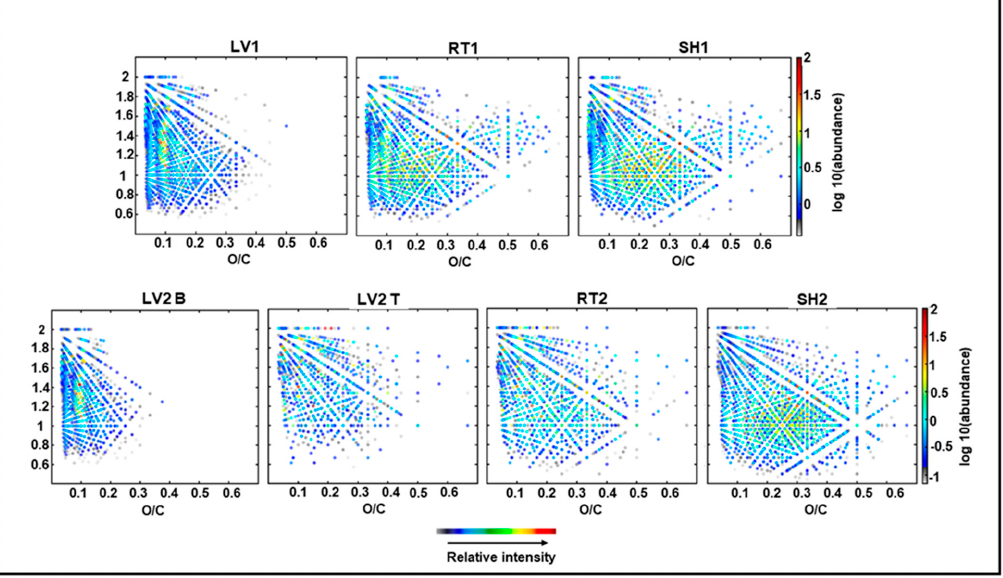
Figure 4. Van Krevelen diagrams (color-coded for relative intensity) for the O x compounds detected in the pyrolysis oil distillates LV1, RT1, and SH1 condensed at 130 °C and pyrolysis water-based distillates LV2B, LV2T, RT2, and SH2 condensed at 70 °C by APPI FT-ICR MS.